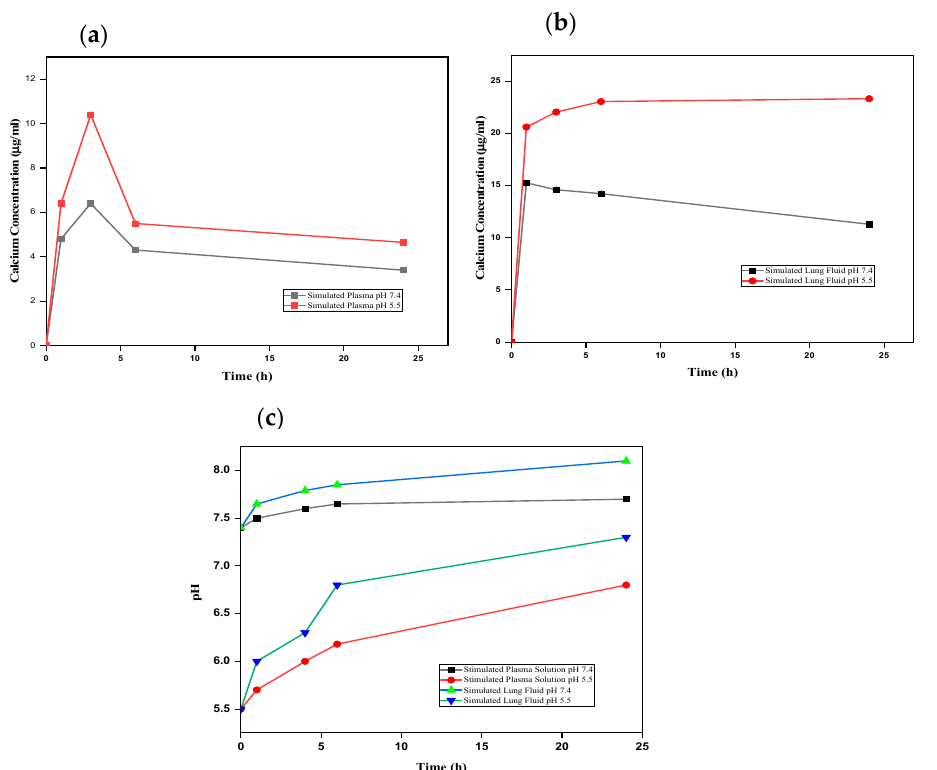
Figure 11. Dissolution analysis of nCA. ( a ) Calcium ion released from nCA in simulated plasma at pH 7.4 and 5.5. ( b ) Calcium ion released from nCA in simulated lung fluid at pH 7.4 and 5.5. ( c ) The alkalisation profile of nCA in both simulated plasma solution and simulated lung fluid at pH 7.4 and 5.5.